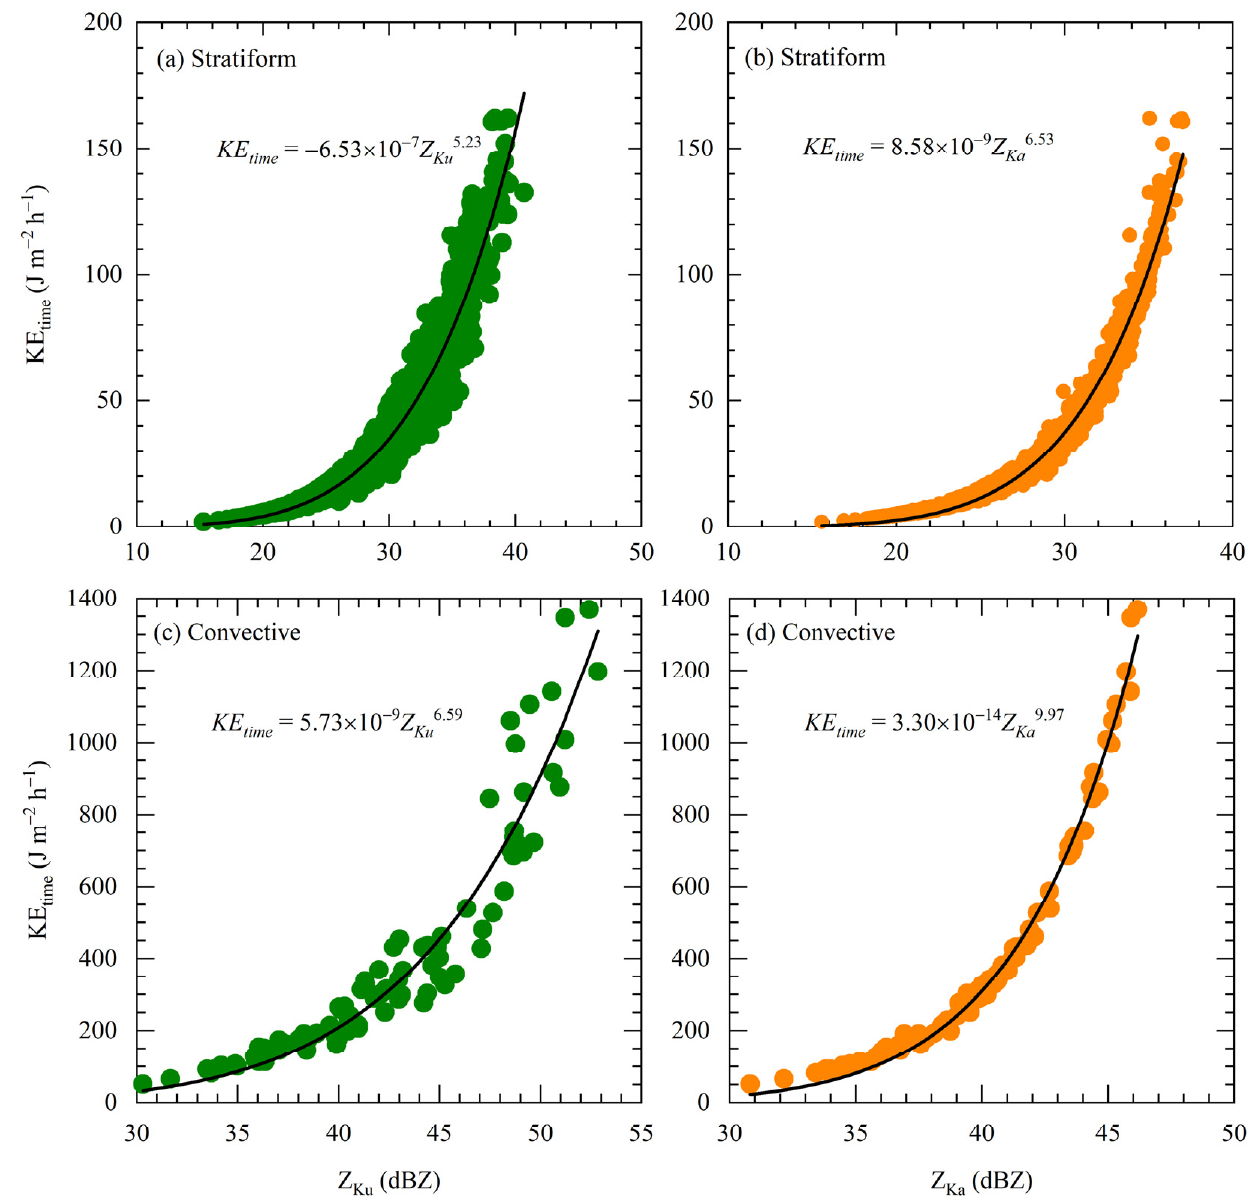
Figure 15. Scatterplots of KE time vs. Z Ku and KE time vs. Z Ka , and the fitted KE time – Z Ku and KE time – Z Ka relations for ( a , b ) stratiform and ( c , d ) convective rainfall in Zhaosu.